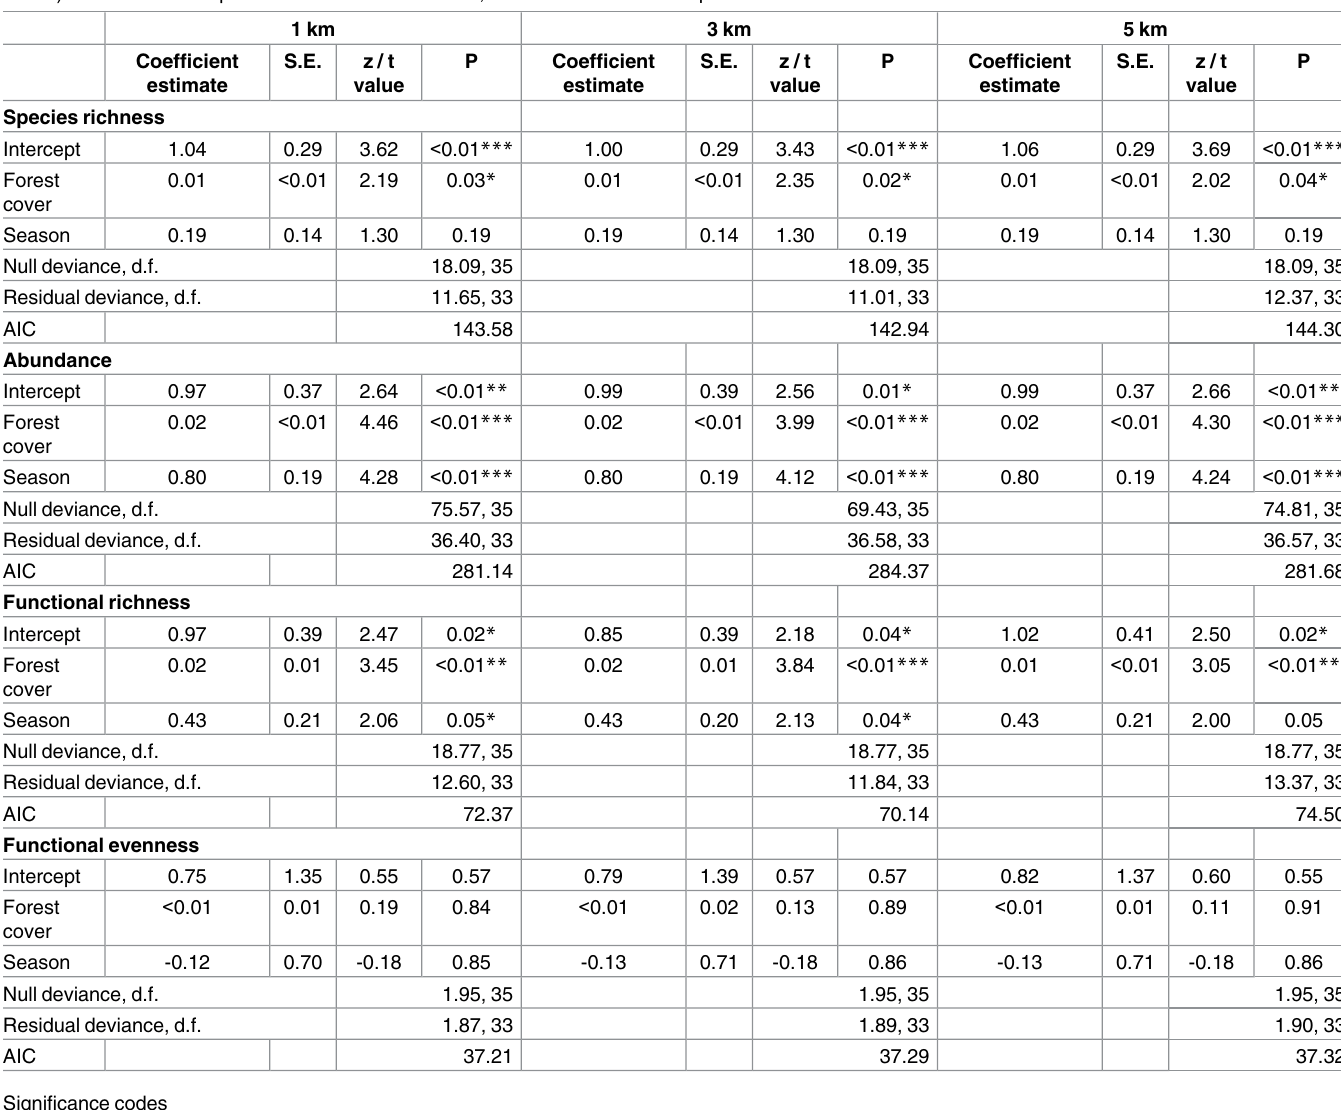
Table 5. Summaryof generalized linear models results. Bat diversity parameters (species richness, abundance,functionalrichness and functionalabun- dance) were tested as dependentvariables. In all cases, the fitted model was Y = μ + Forest cover + Season + ε . 1